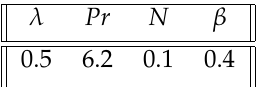
Table 1. Governing physical